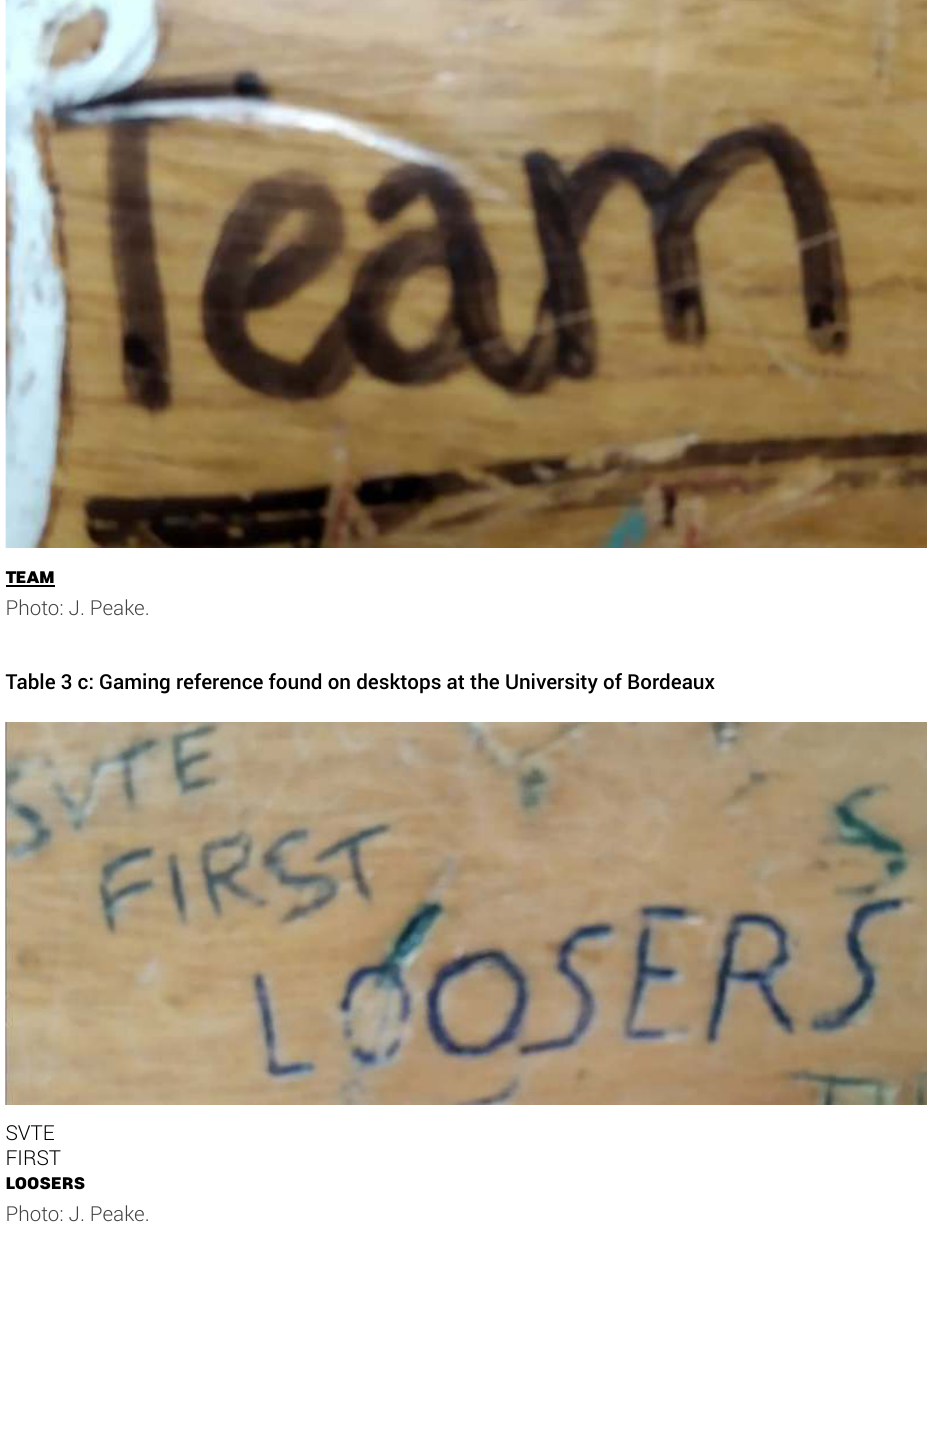
Table 3 b: Gaming reference found on desktops at the University of Bordeaux